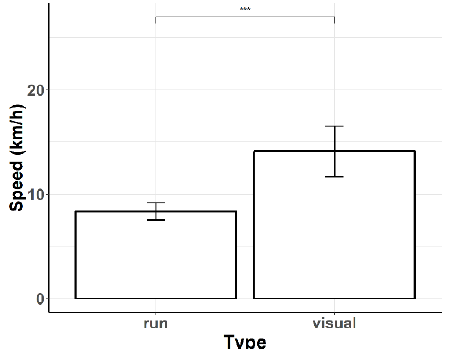
Figure 5. Visual speed underestimation. Speed of the visual scene that was perceived as matching running / treadmill speed. The bars represent the means and the error bars the 95% confidence interval of those means.